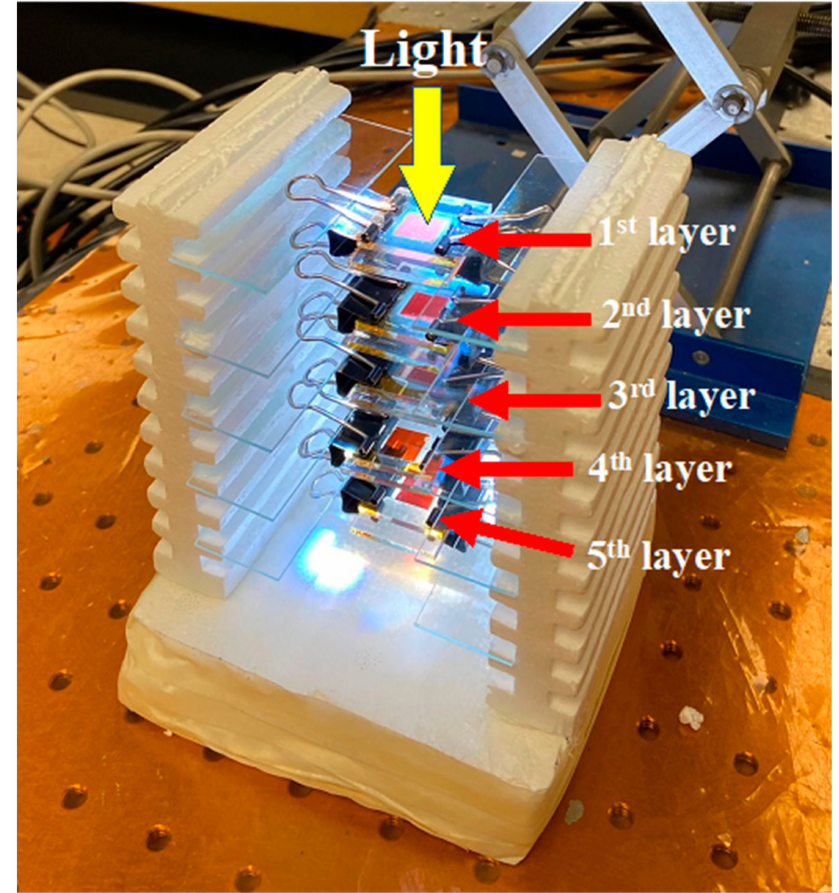
Figure 11. Photograph of 3D solar harvesting through 5